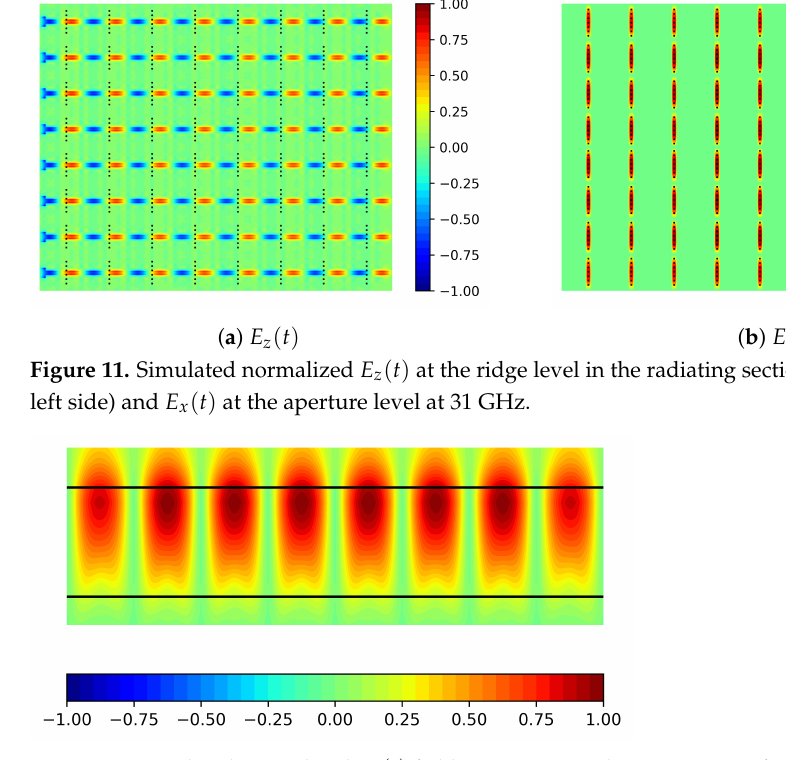
Figure 12. Simulated normalized E x ( t ) field component at the cross section for the first row at 31 GHz (TS vertical limits indicated in black; y and z dimensions not to scale).